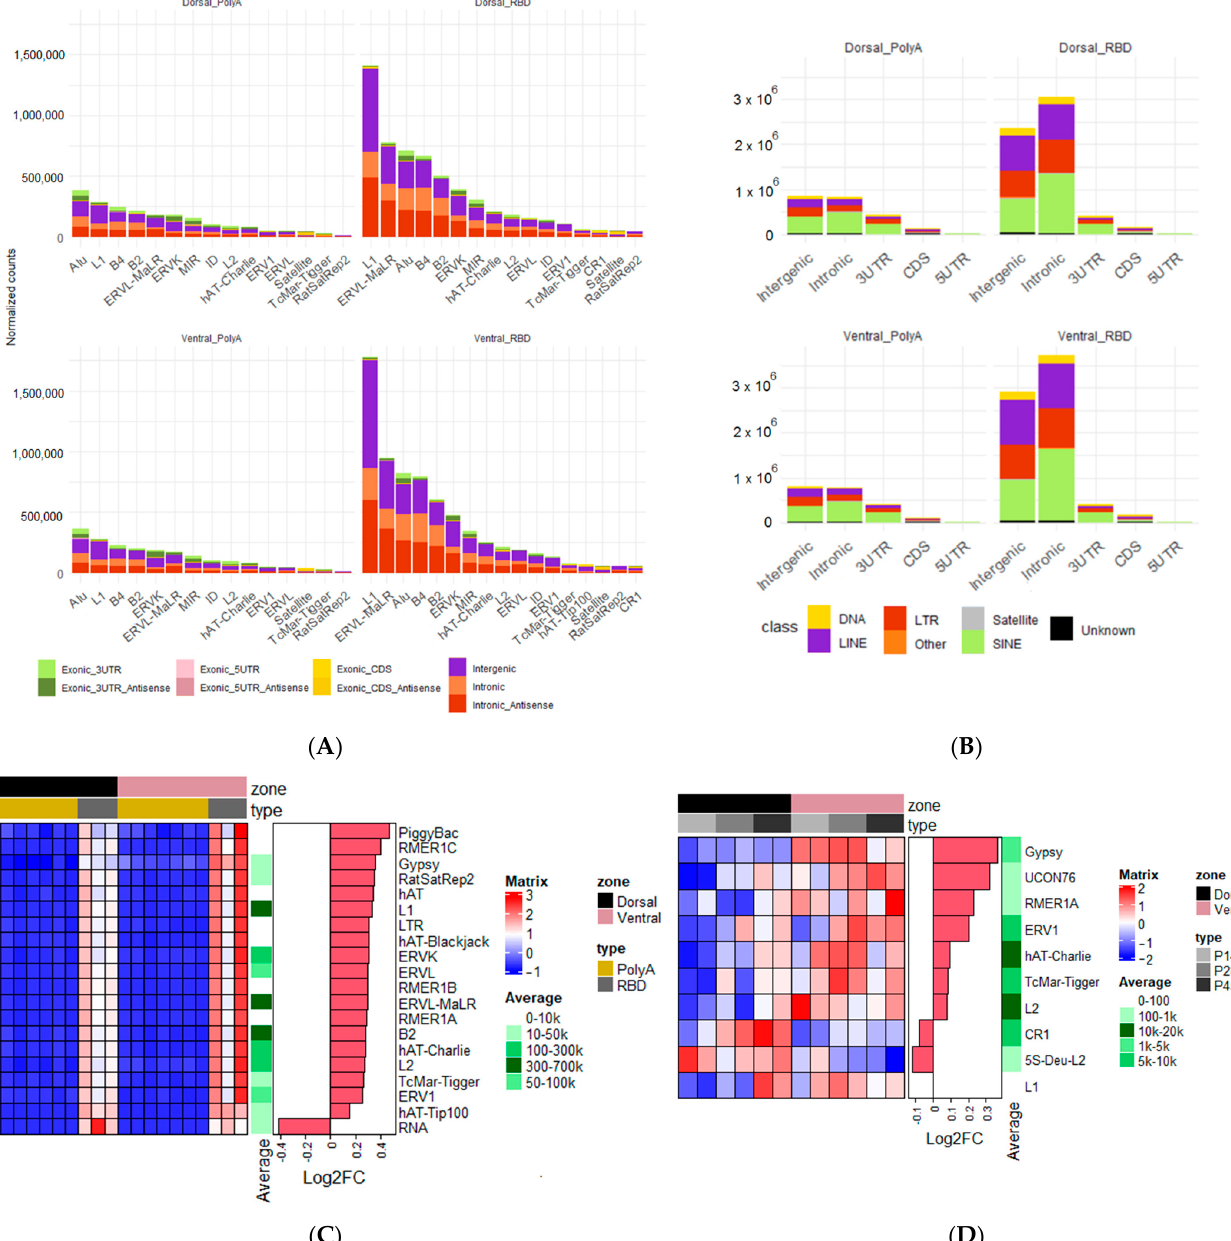
Figure 8. ( A ) Normalized read count per repeat family, summarized by number of different genic/intergenic positioned loci in each. ( B ) Normalized read count per genic/genomic position, summarized by repeat class. ( C ) Heatmap showing z-scored repeat-expression difference between four datasets (left), read number averaged across all datasets (middle), and relevant log 2 fold change (right). All changes were significant for RBD dataset with p . adj < 0.1. ( D ) Heatmap with similar measurements for developmental dataset from [14].